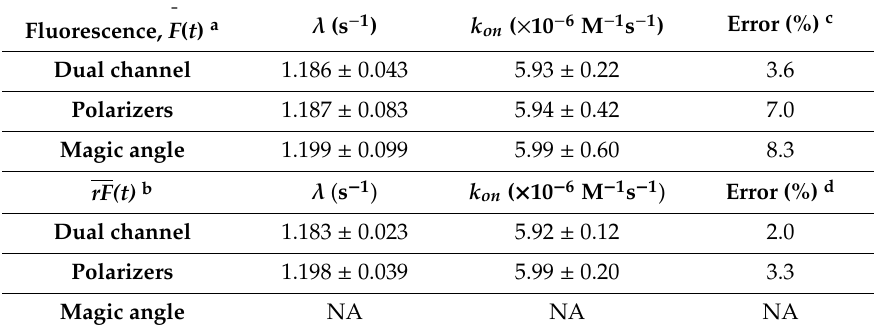
Table 3. The eigenvalues ( λ ) and calculated association rate constants (k on ) of the association reaction of BcO (20 nM) and AV (200 nM) at 20 ◦ C, obtained with the F ( t ) and rF ( t ) sensing modalities, and acquired by the tree stopped-flow methodologies.